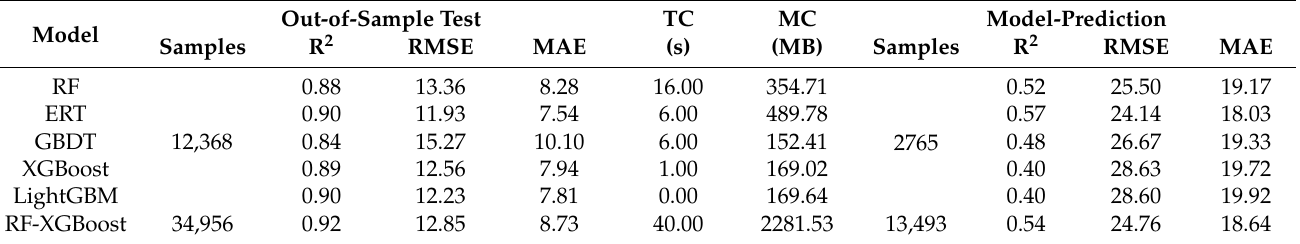
Table 4. A comparison of the model performances of different ensemble models and the RF-XGBoost model. TC and MC refer to the time and memory of computer consumption during the model